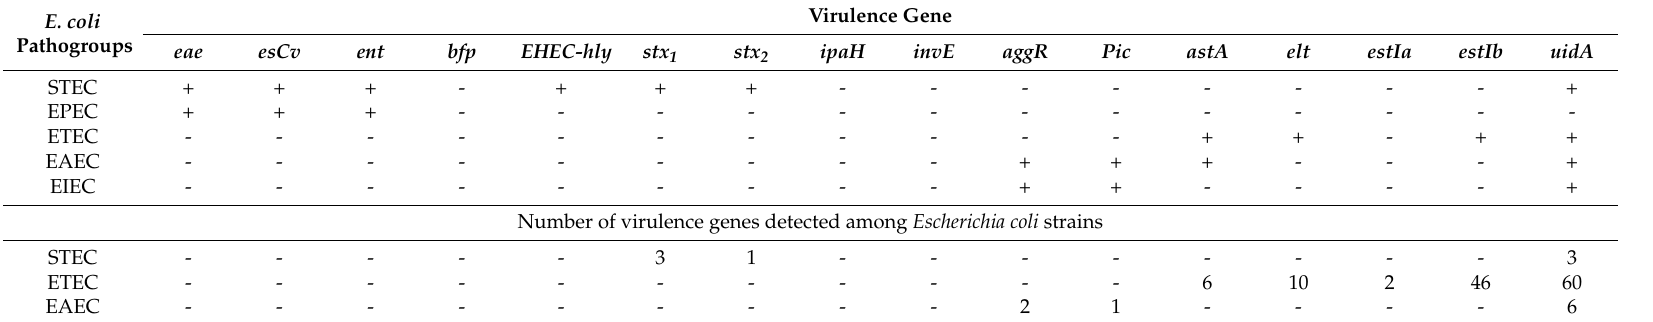
Table 3. Virulence genes detected by 16-plex PCR in Escherichia coli isolates and in the six control